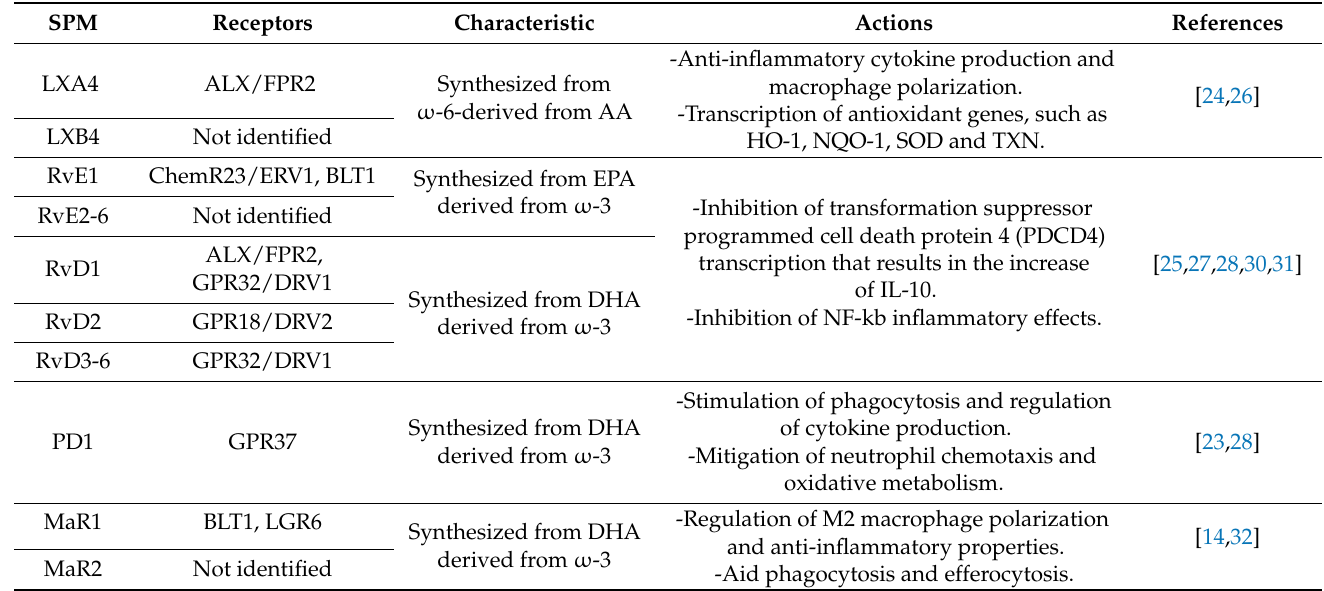
Table 1. Specialized proresolving lipid mediators and its